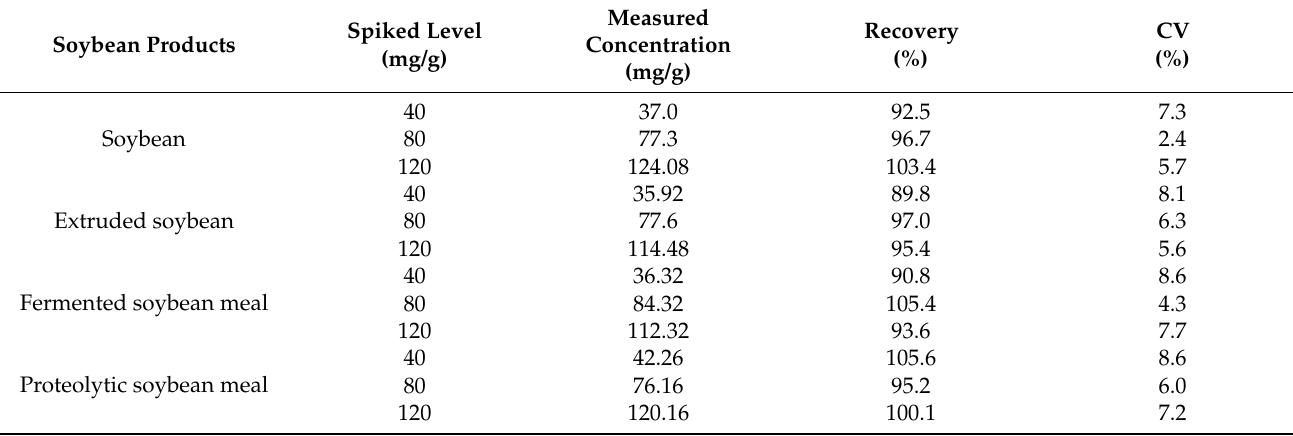
Table 2. Recoveries of glycinin spiked in various soybean products ( n =